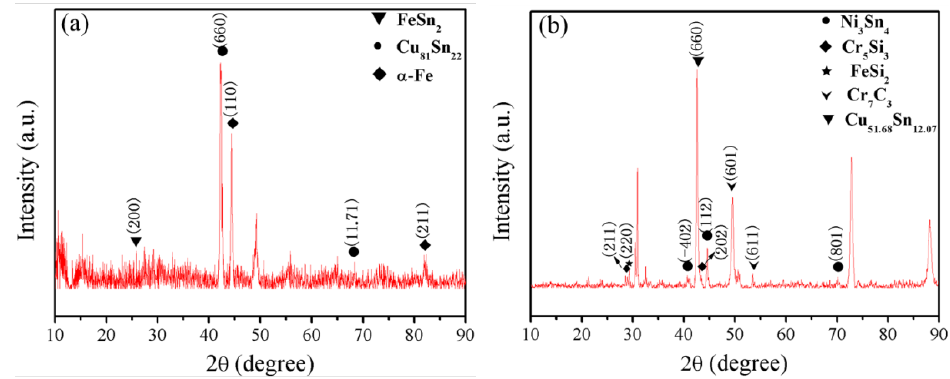
Figure 8. X-ray diffraction patterns of the interfacial regions in the samples ( a ) without interlayer and ( b ) with interlayer.